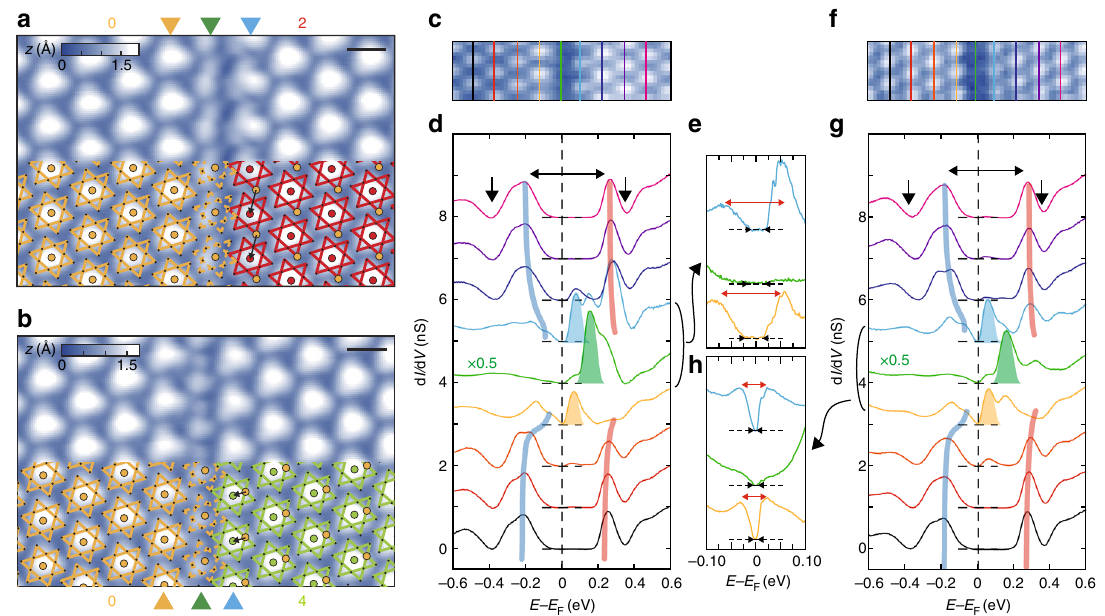
Fig. 2 Atomic and electronic structure of domain walls and edges. a , b Constant current STM images ( V s = − 0.5 V, I t = 500 pA, and L 2 = 9.7 × 6.4 nm 2 ) of the second and the fourth domain wall, superimposed with the schematic David-star superlattice. The indices for each domains are indicated in Fig. 1a. The black arrows represent the phase shift between neighboring domains. The center and edges of domain walls are marked by green and yellow ( blue ) triangles , respectively. Scale bar , 1 nm. c , f The STM images ( V s = − 1.2 V, I t = 100 pA) are simultaneously acquired with the STS measurements. d , g Spatially resolved d I /d V spectra cross the domain walls. Each spectrum is averaged in the region marked by same colored lines in the STM images c , f . The evolution of the incoherent peaks in the domain is displayed by the semitransparent blue and red curves . The double-headed black arrows display the gap size of domains. The single-headed black arrows indicate the subband splitting. The in-gaps states are highlighted by the fi lled gaussian-shaped peaks. e , h High-resolution STS spectra at the domain wall and edges. The double-headed black and red arrows indicate the zero conductance region and the peak-to-peak splitting at the domain edges, respectively. Spectra are equally shifted in intensity for